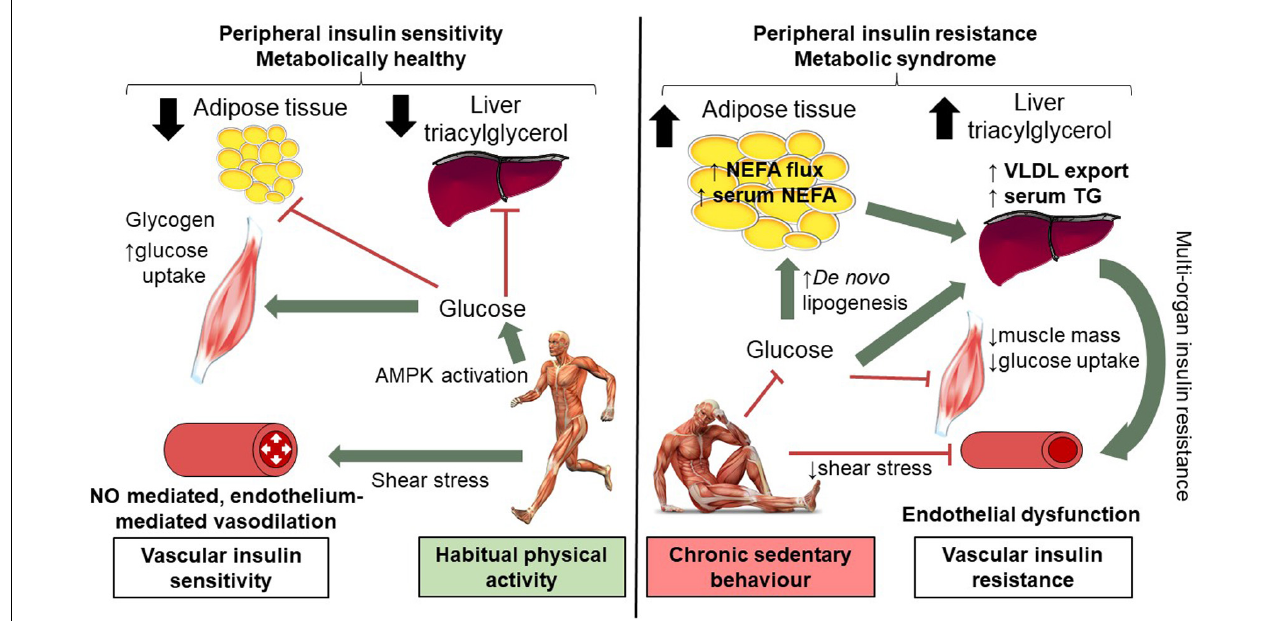
FIGURE 3 | Mechanisms of short-term (14 days) physical inactivity and its role in the development of cardio-metabolic complications. Low levels of physical activity are associated with reduced shear stress; brachial artery endothelial function is compromised as a consequence of 14 days inactivity, as such NO mediated endothelium vasodilation is worsened. Low levels of physical activity alter insulin and AMPK signaling pathways in skeletal muscle and reduce GLUT4 translocation and glucose uptake. Skeletal muscle insulin resistance means additional glucose substrate for de novo lipogenesis in adipose tissue and the liver with expansion of adipose tissue and intra-hepatic lipid. Systemic insulin resistance, higher levels of circulating NEFA and TG are observed. Vascular insulin resistance may also contribute to peripheral insulin resistance in part due to reduced blood flow. In contrast, in habitually active individuals shear stress mediates endothelial-mediated vasodilatation (which together with intact skeletal muscle AMPK and insulin signaling) contributes to preserved peripheral insulin resistance. This figure is adapted from Bowden Davies et al. (2019) with full permissions from the authors and